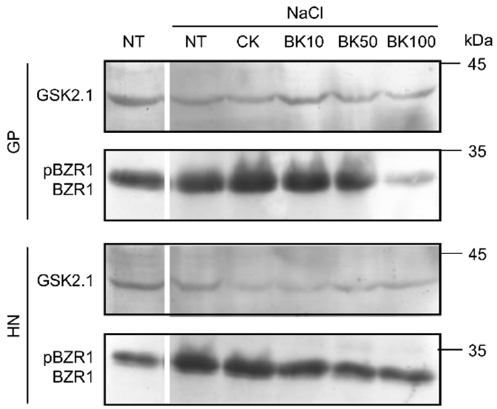
Table 7. Results of two-way ANOVA for two barley genotypes (Golden Promise and Haruna Nijo) grown in two conditions (control conditions and salt stress induced by 150 mM sodium chloride) calculated for genes controlling brassinosteroid (BR) biosynthesis ( HvDWF4 ) and the BR signaling pathway ( HvBRI1 , HvBAK1 , HvBSU1 , HvGSK1.1 , HvGSK1.2 , HvGSK1.3 , HvGSK2.1 , HvGSK2.2 , HvGSK3.1 , HvGSK4.1 , HvBZR1 ), as determined in leaves (3rd and 4th). MS—mean square; F—F- Figure 9. Immunodetection of Hv BZR1 and Hv GSK2.1. pBZR1 indicates the phosphorylated form of Hv BZR1; BZR1 indicates the dephosphorylated form of Hv BZR1. Following the results of RNA-Seq analysis and our observations regarding Hv GSK2.1